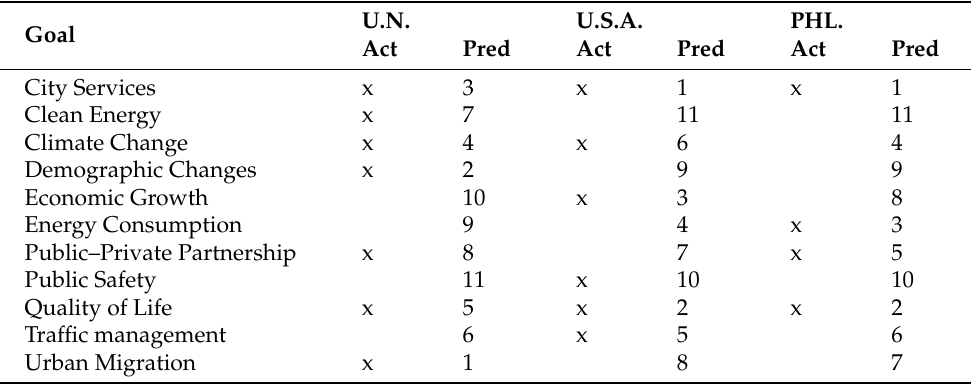
Table 6. Comparison of Smart City objectives for each document analyzed and the predicted rank of the topic in the document.